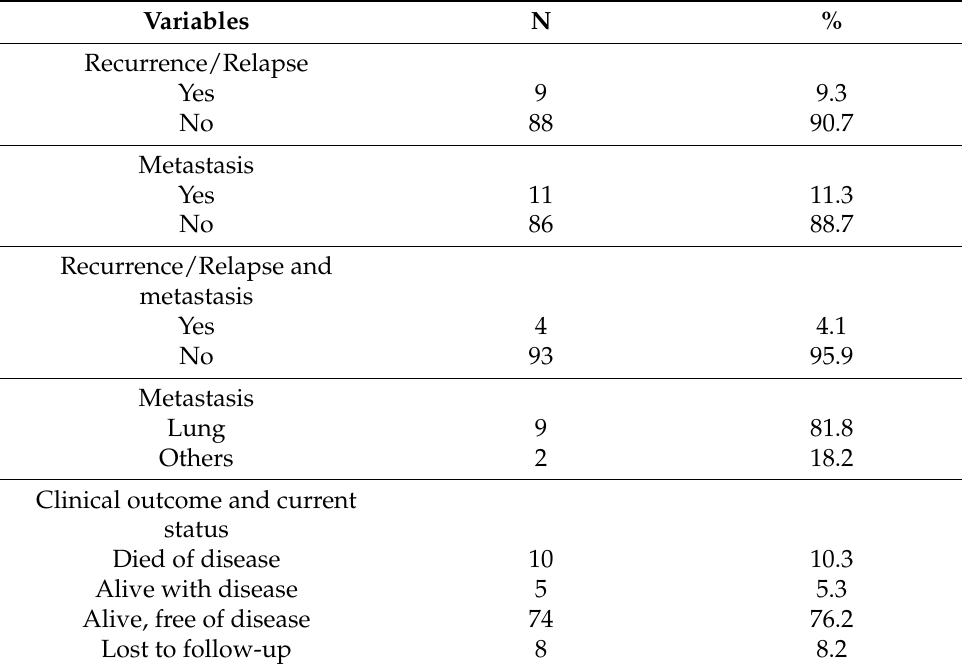
Table 2. Solitary fibrous tumor. Follow-up data (N = 97). Median follow-up (90 months).